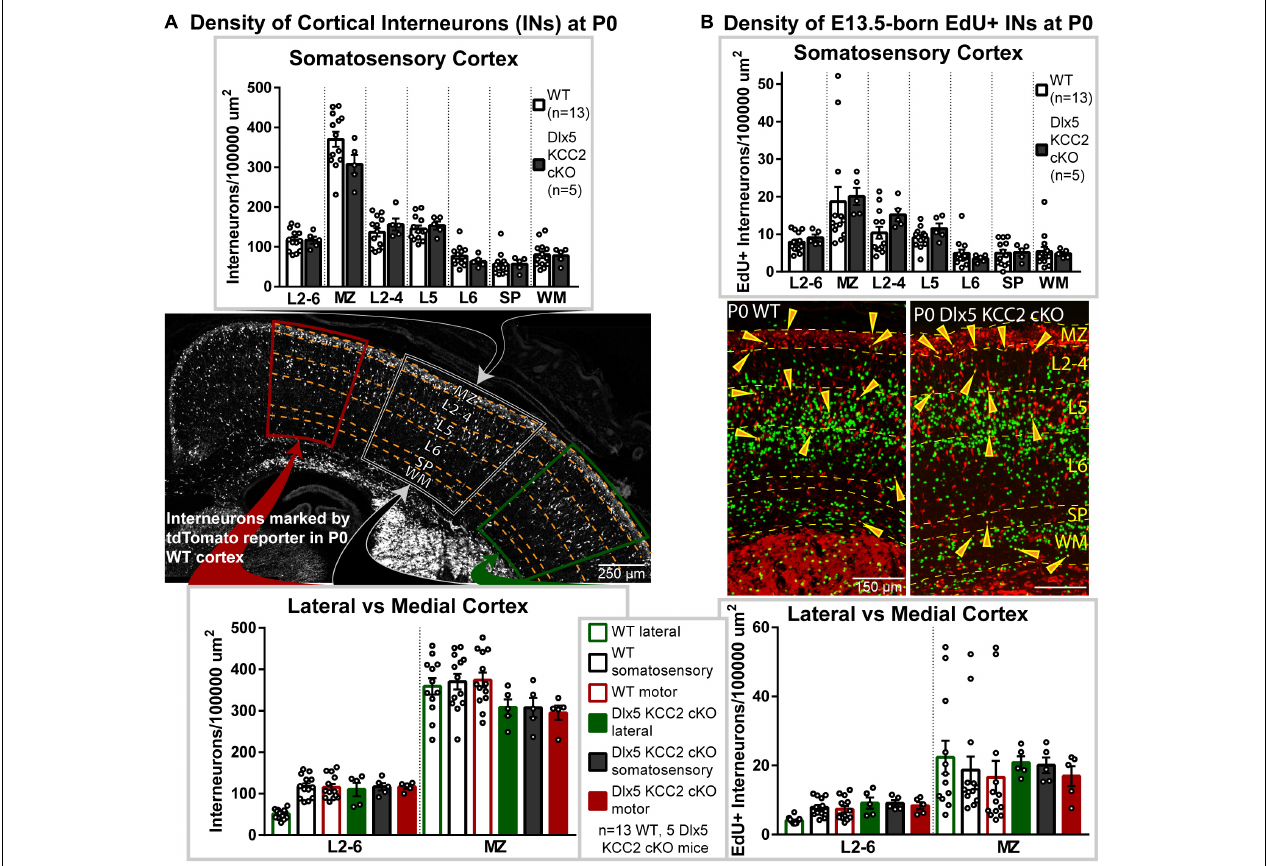
FIGURE 3 | Interneuronal loss of KCC2 does not alter perinatal IN migration. (A) Distribution of INs, marked by tdTomato cre reporter, in P0 Dlx5 KCC2 cKO and age-matched WT. Top graph compares cortical layers of somatosensory cortex, and bottom compares medial and lateral cortex. Center image shows exemplar distribution of INs in P0 WT cortex with labels of layers/regions used for comparison. (B) Distribution of E13.5-labeled EdU+ INs in P0 Dlx5 KCC2 cKO and age-matched WT. EdU was injected into G13.5 pregnant dams, and distribution of EdU+ INs (shown in center images) was compared between Dlx5 KCC2 cKO and WT in cortical layers of somatosensory cortex (top graph), and between lateral and medial cortex (bottom graph). For both (A,B) , no significant differences found by one-way ANOVA with Sidak’s multiple comparisons. Comparisons were also made between individual layers of medial and lateral cortex with no differences found (data not shown). For (A,B) , n = 13 WT and 5 Dlx5 KCC2 cKO mice. Abbreviations: (MZ), marginal zone; (L2-4), layers 2-4; (L5), layer 5; (L6), layer 6; (layers 2-6), L2-6; (SP), subplate; (WM), white